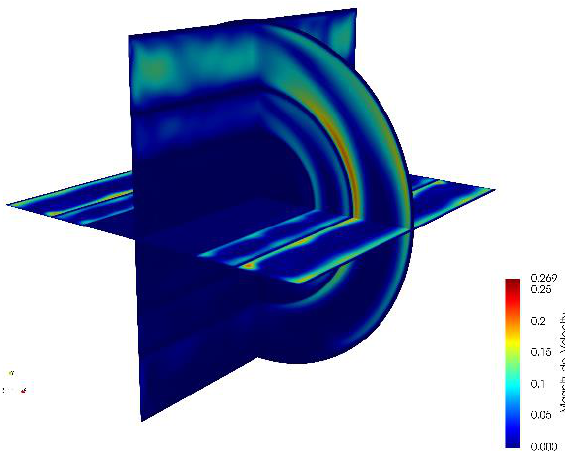
Fig. 10. Velocity field after 30 minutes .